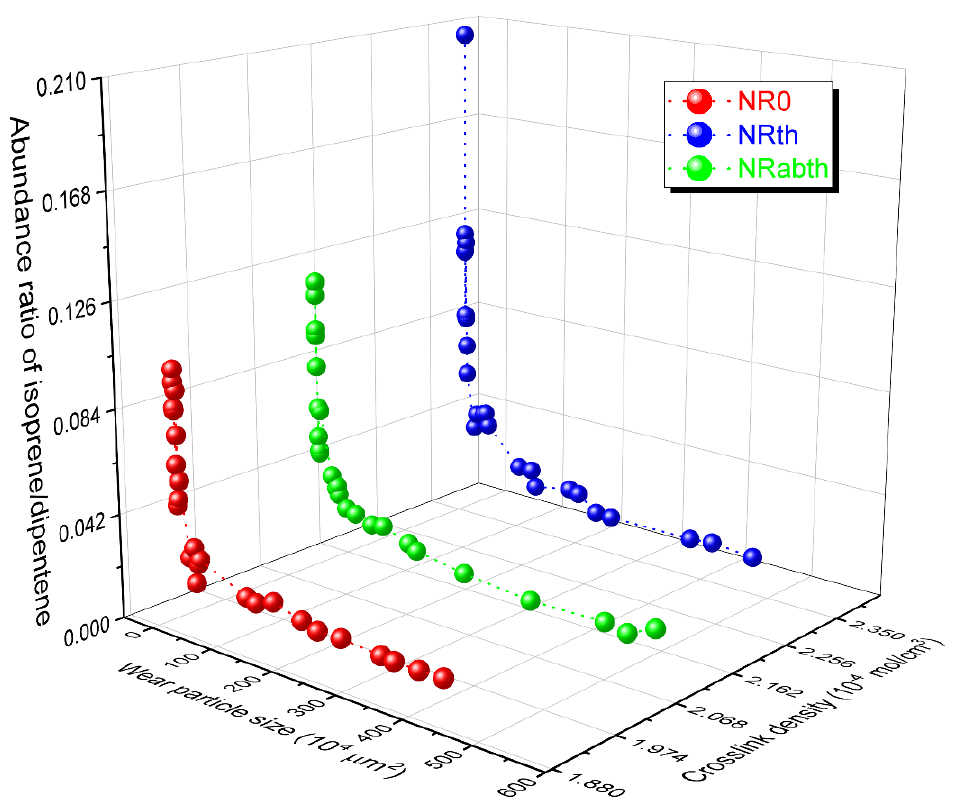
Figure 4. Variations of the isoprene/dipentene ratios of the wear particles with the wear particle size and crosslink density. The wear particle size is the multiplication of the major and minor axes.